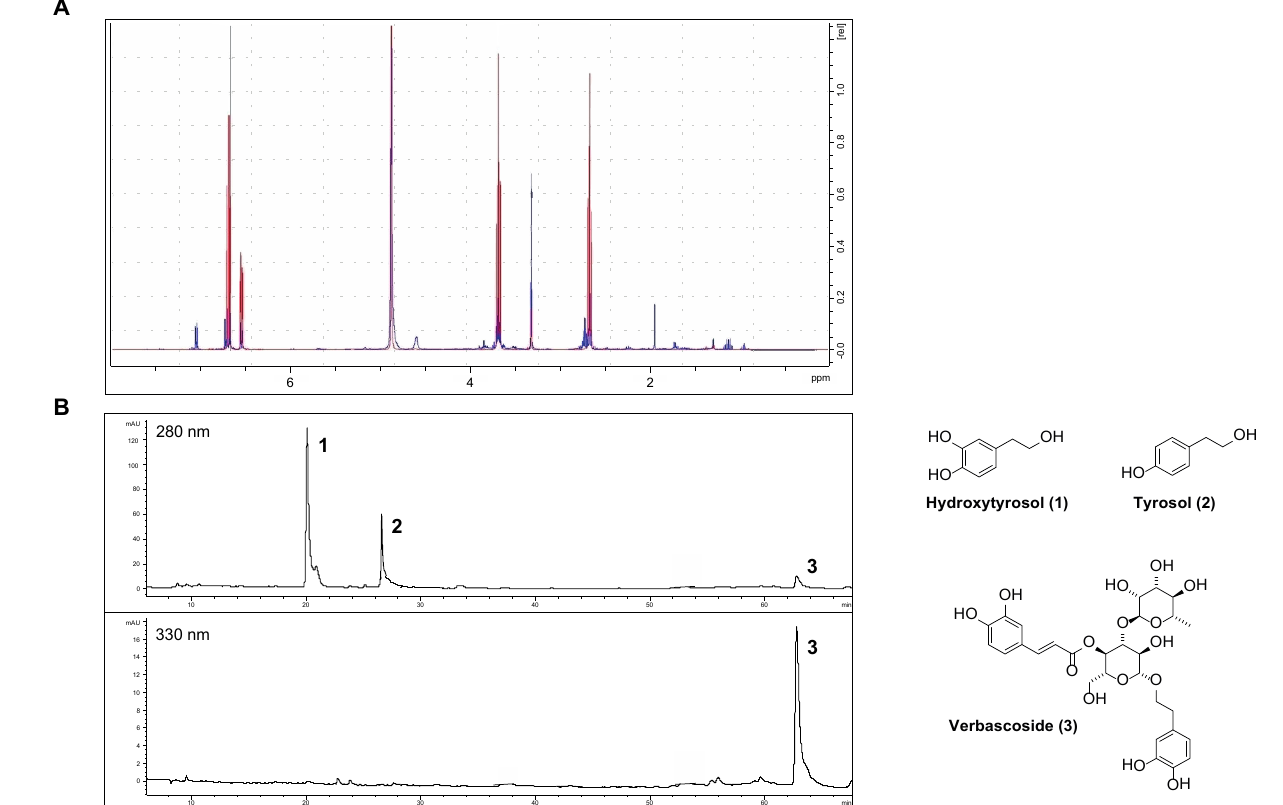
Figure 1. Chemical characterization of the Tuscany Extract (TE): ( A ) 1 H NMR spectra of HTyr (red) and TE (blue); ( B ) HPLC chromatogram of TE a 280 and 330 nm.